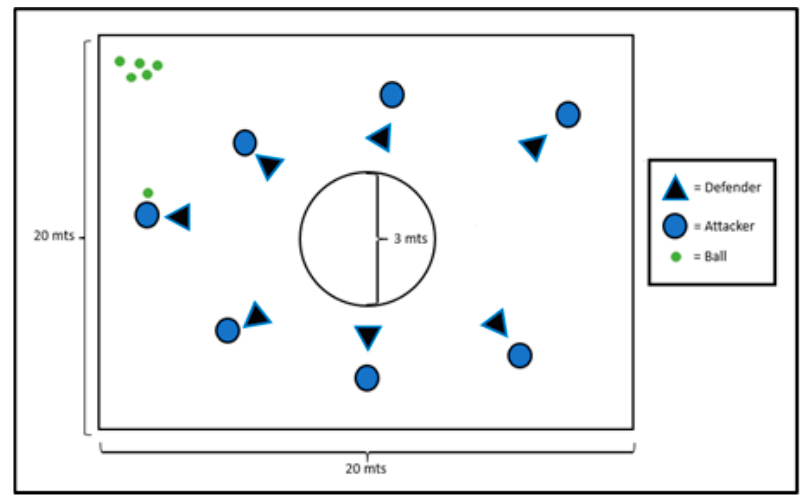
Figure 1. General view of the structure of the NLP exercise.